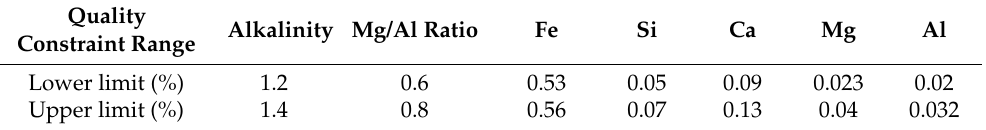
Table 5. Restriction range of sinter